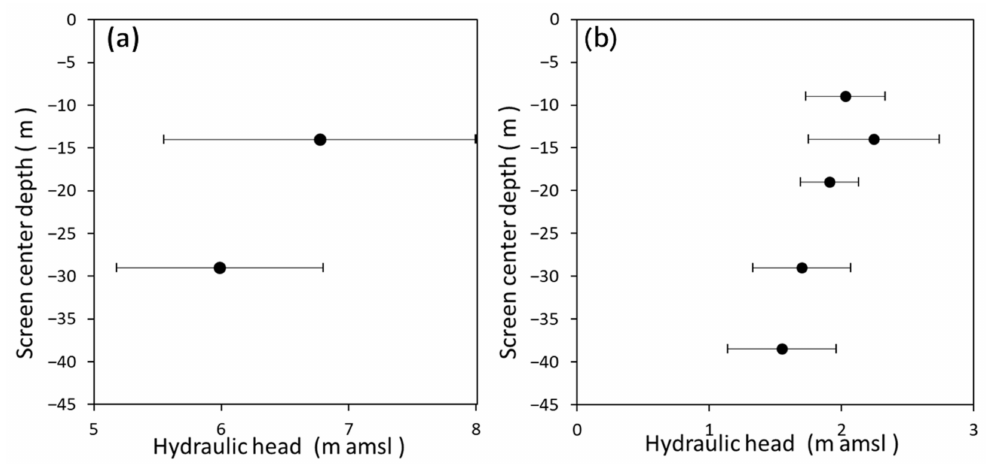
Figure 2. Hydraulic head variation at different depths: ( a ) G8 and ( b ) G3.